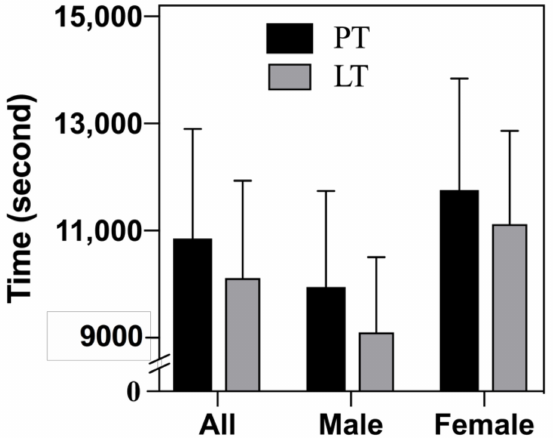
Figure 2. Comparison of the completion time of the half-marathon. The data are represented as mean ± standard deviation. Placebo treatment (PT); Lactobacillus plantarum PS128 treatment (LT). p < 0.05 was considered to be a statistically significant difference within and between the